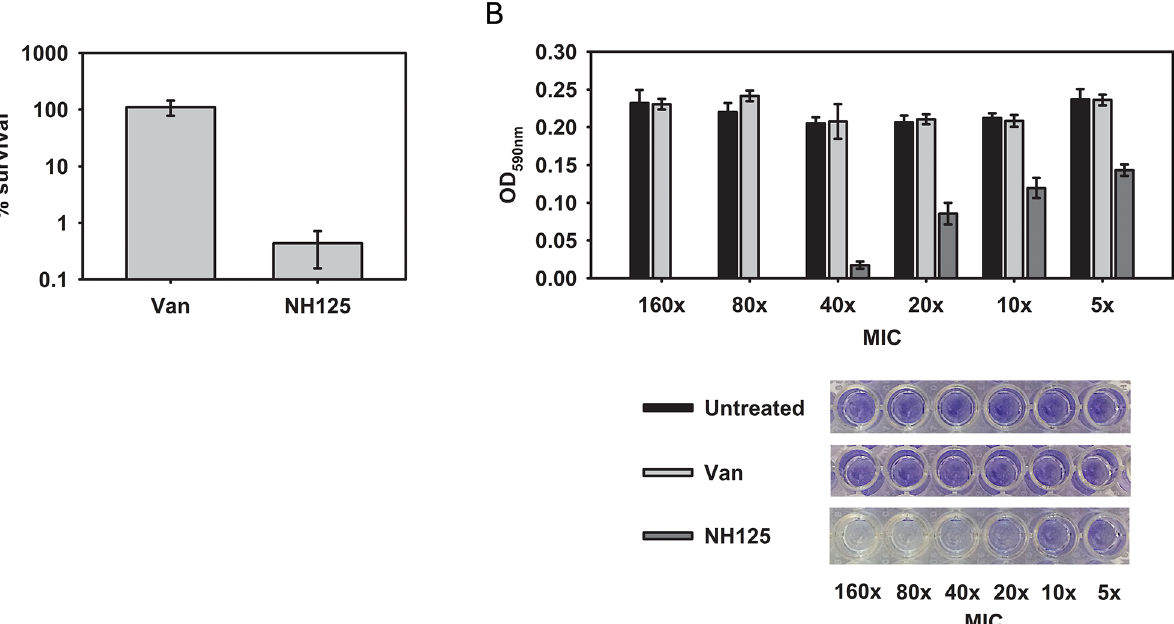
Fig 5. NH125 eradicates MRSA biofilms. (A) MRSA biofilms formed on 13 mm cellulose ester membranes for 24 hours were treated with 10X MIC of vancomycin (Van) or NH125 for 24 h. Survival was measured by comparing the number of viable cells in biofilms between non-treated and treated samples. (B) MRSA biofilms grown in a 96-well microtiter plate for 48 h were treated with the indicated concentration of vancomycin or NH125 for 24 h. The remaining biofilms were stained with 0.1% crystal violet dissolved with 95% ethanol and OD 590 nm was measured. Results are shown as means ± s.d.; n = 3.